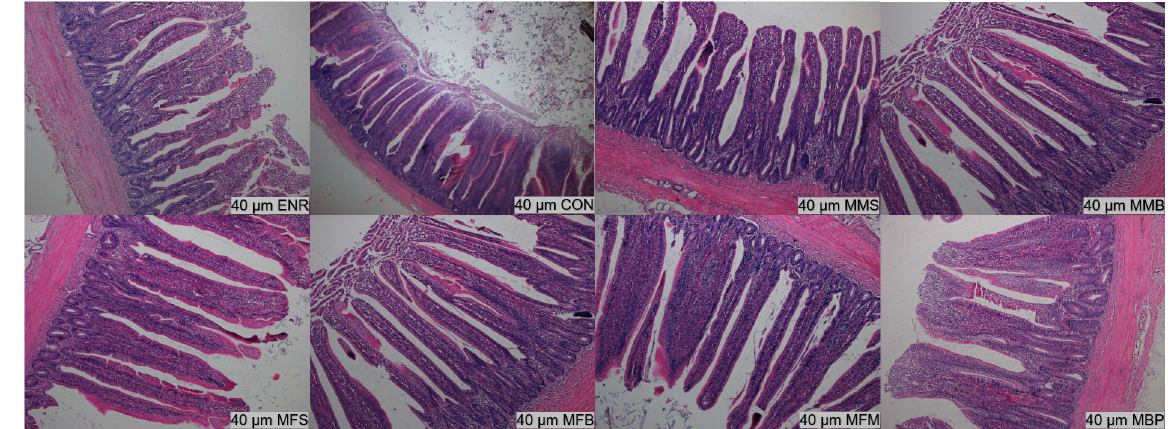
Fig 4. Histological structure of Hematoxylin and Eosin (H&E) staining ileum at 42 day of age. CON, control diet; ENR; CON + 100 mg/kg ENR, MMS; CON + 2000 mg/kg MOS + 300 mg/kg MAN + 1500 mg/kg SB, MMB; CON + 2000 mg/kg MOS + 300 mg/kg MAN + 500 mg/kg BS, MFS; CON + 2000 mg/kg MOS + 9000 mg/kg FOS + 1500 mg/kg SB, MFB; CON + 2000 mg/kg MOS + 9000 mg/kg FOS + 500 mg/kg BS, MFM; CON + 2000 mg/kg MOS + 9000 mg/kg FOS + 300 mg/kg MAN, MBP; CON + 2000 mg/kg MOS + 500 mg/kg BS + 37 mg/kg PT. SB; Sodium butyrate, FOS; Fructose oligosaccharide, PT; Phytase, BS; Bacillus subtilis, MOS; Mannose oligosaccharide, MAN; Mannanase.